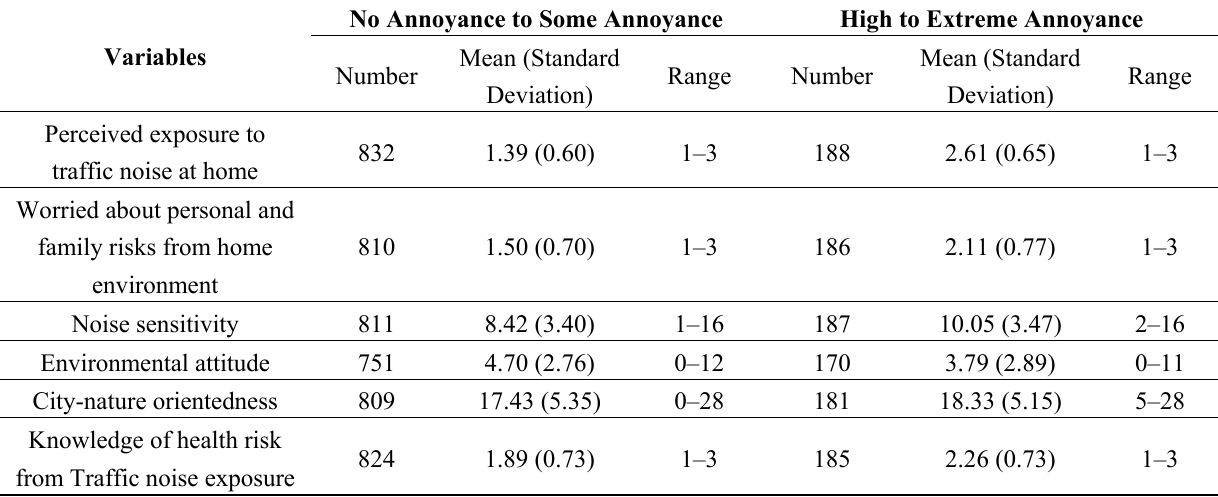
Table A2. The distribution of some explored covariates between the strata of noise annoyance (high to extreme and